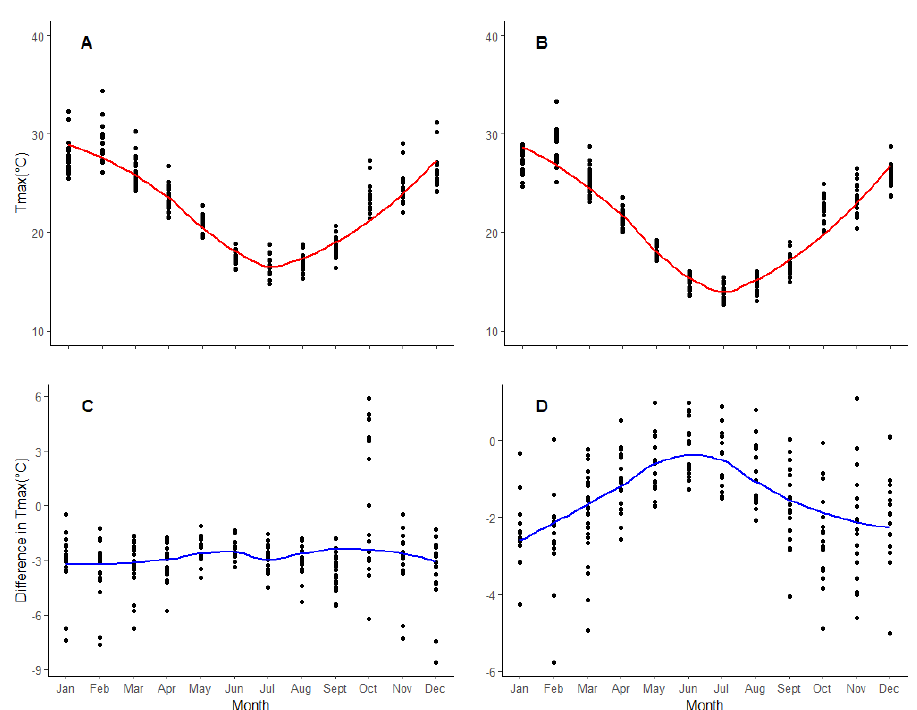
Figure 2. Daily maximum temperature by month at site A ( A ) and B ( B ) (red line shows the general monthly temperature trend); Panels ( C ) and ( D ) represent the temperature difference between the 10 independent sensors and the single sensor within the meteorological stations at sites A and B, respectively (blue line showed the general trend).